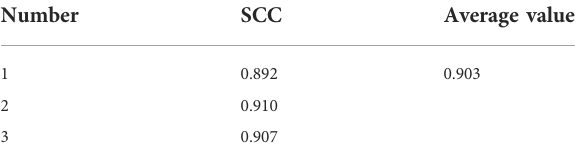
TABLE 2 SCC of the NWPP-EDH model.